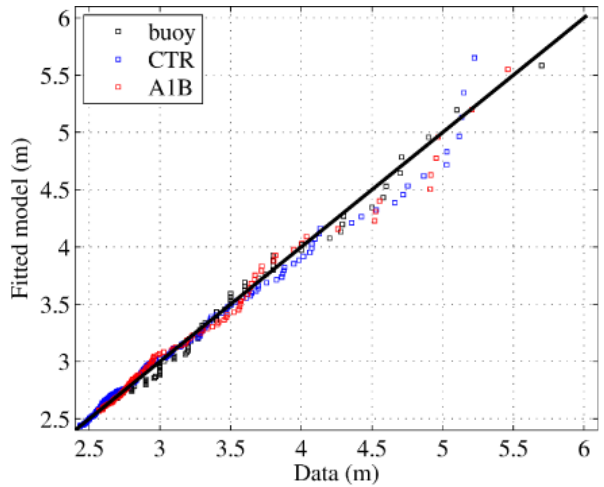
Fig. 5. Quantile plot of the GPD fit at the Ortona buoy. Black: ob- served; blue: CTR run; red: A1B